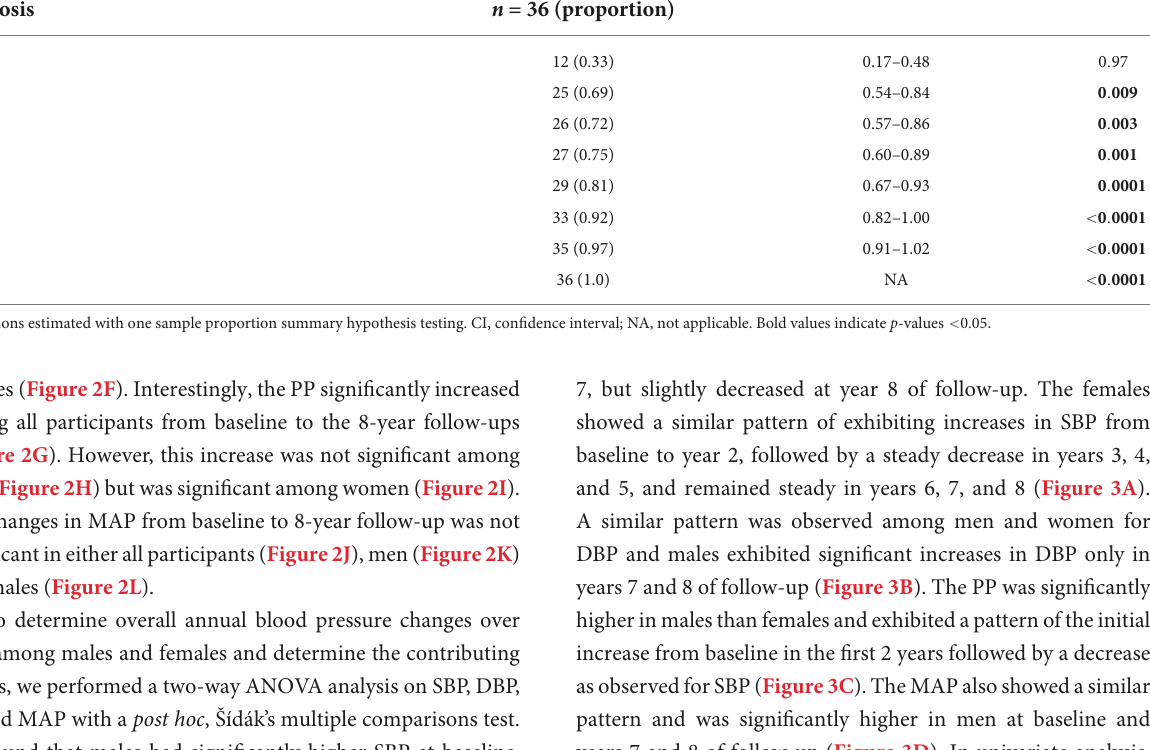
Developed hypertension, n = 36